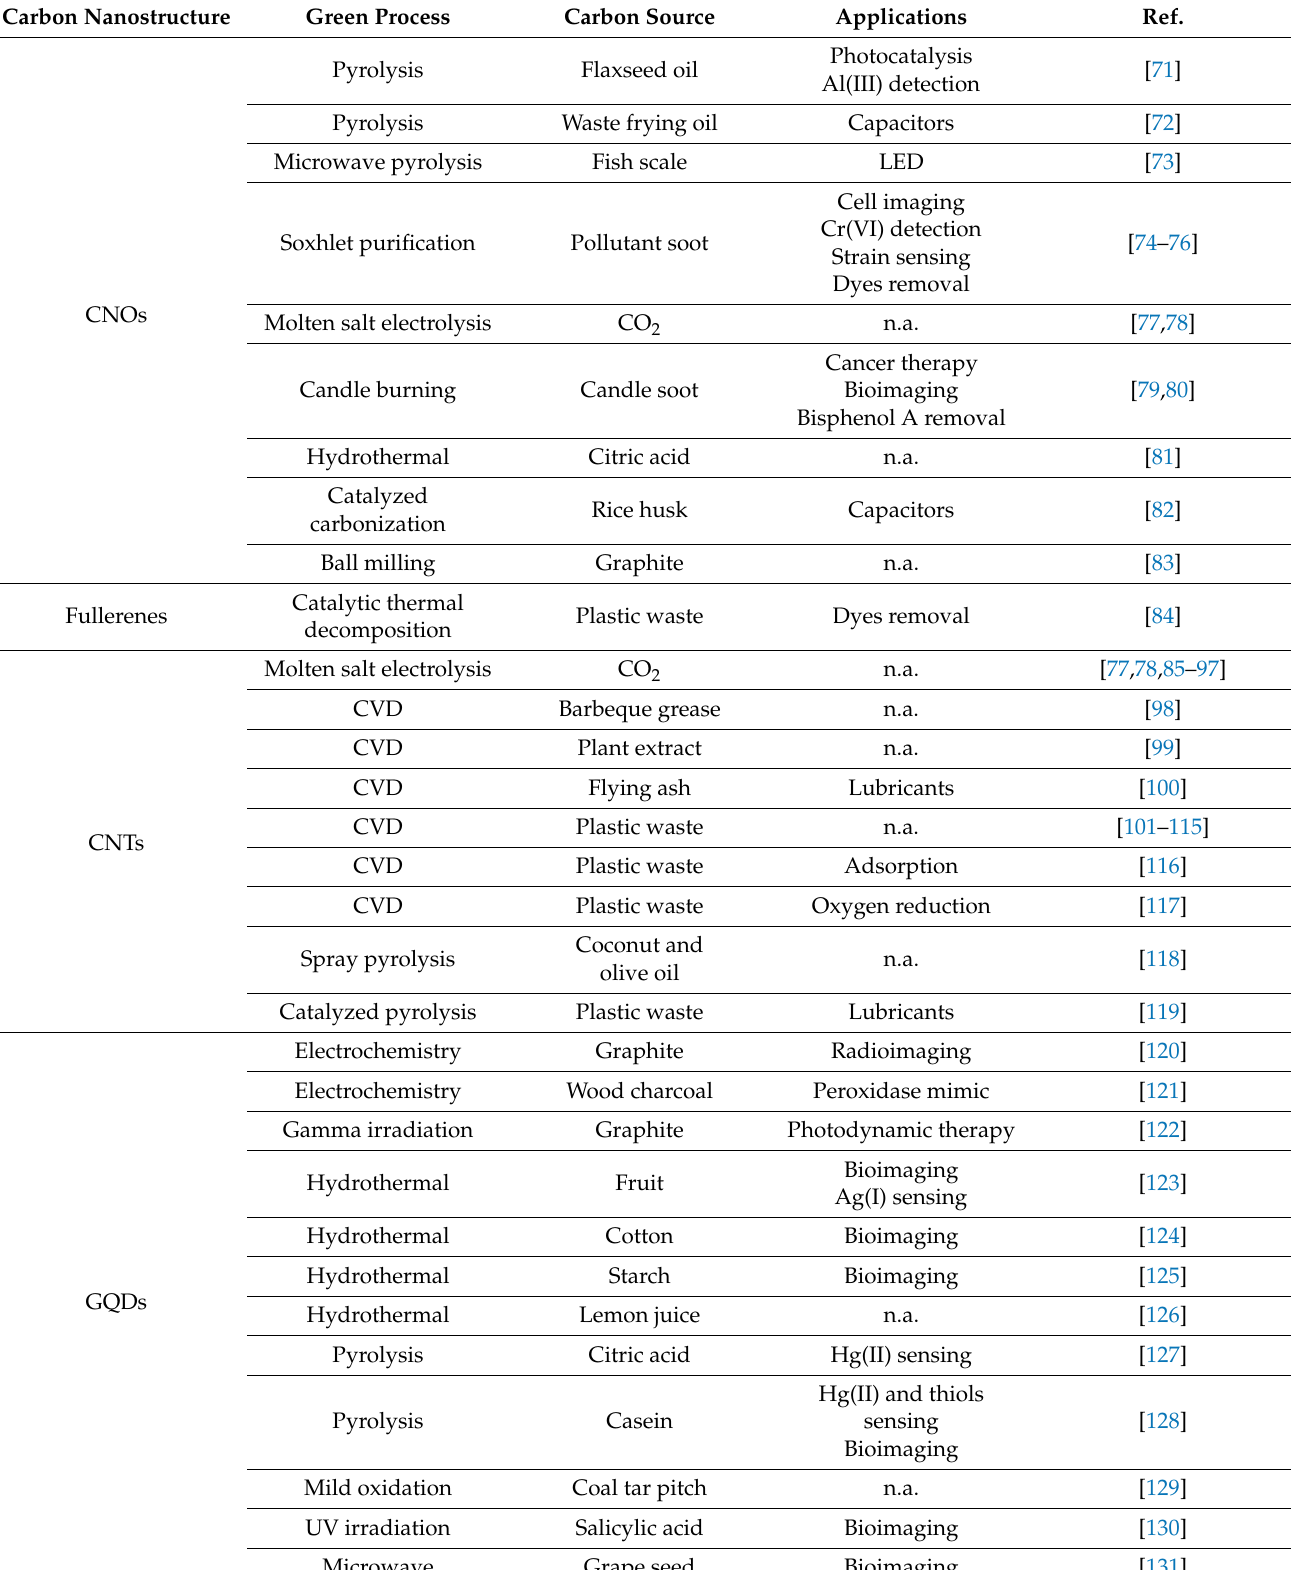
Table 2. Recent examples of green methods to produce graphitic carbon nanostructures using green materials and/or lower energy-demanding